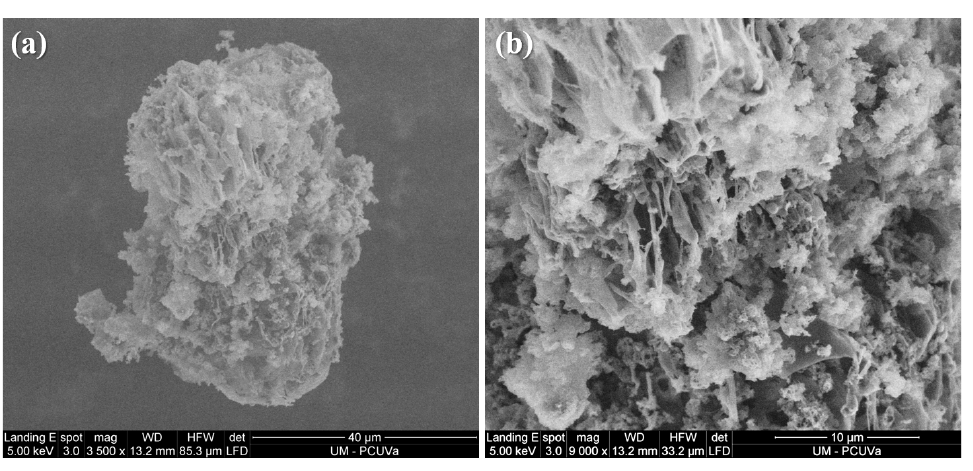
Figure 1. Scanning electron microscopy micrographs of F,O,S ‐ codoped g ‐ C 3 N 4 showing a crumped morphotype at ( a ) 3500× and ( b ) 9000× magnification.